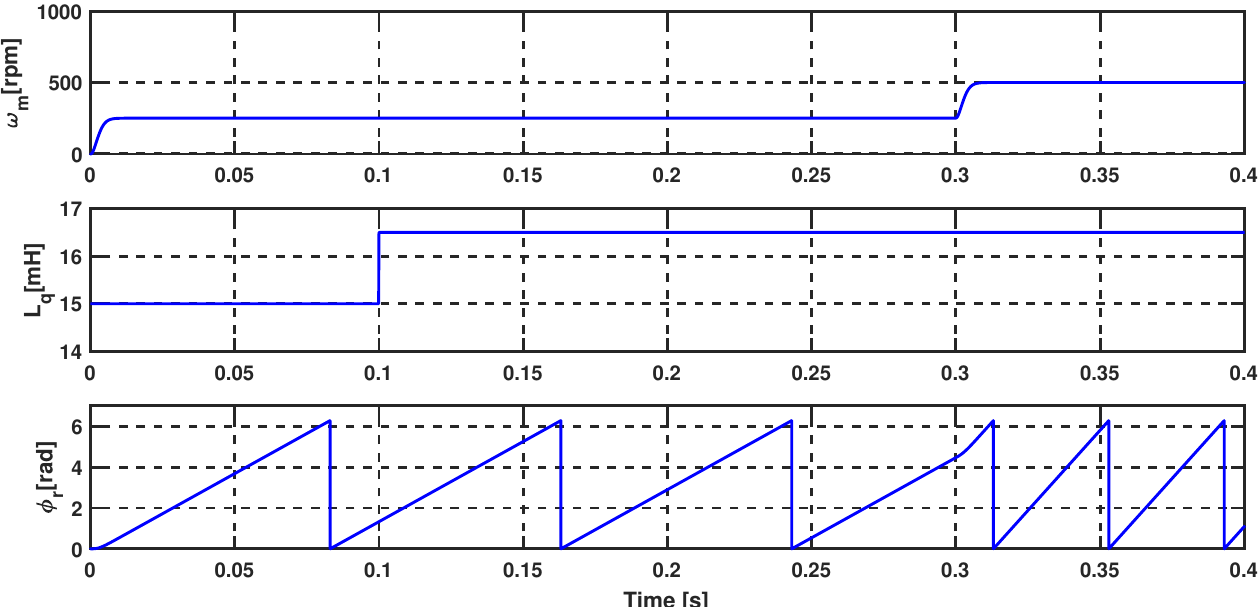
Figure 14. Simulation results of multiple vector 2VV FCS-MPC at step change in the PMSM inductance L q (from top): Speed ω m , inductance L q , and rotor angle φ r .